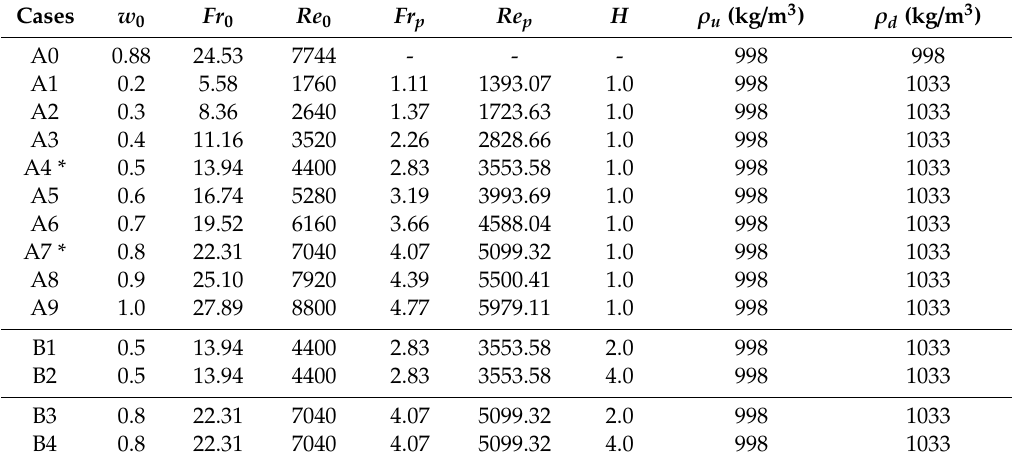
Table 2. The parameters of di ff erent cases. The Froude number Fr p and Reynolds number Re p are defined at the entrance of the pycnocline, corresponding to the initial Froude number Fr 0 and Reynolds number Re 0 . The details of values used in Table 2 can be found in Section